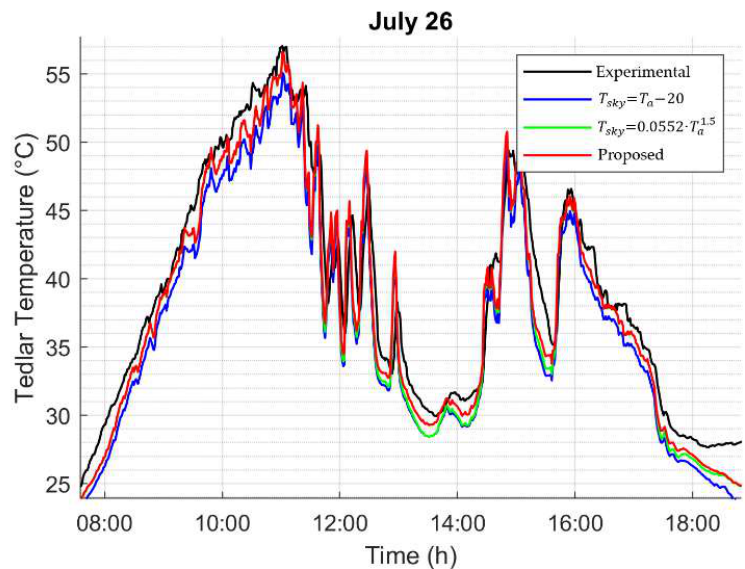
Figure 3. Temperature of tedlar for different sky temperature models.